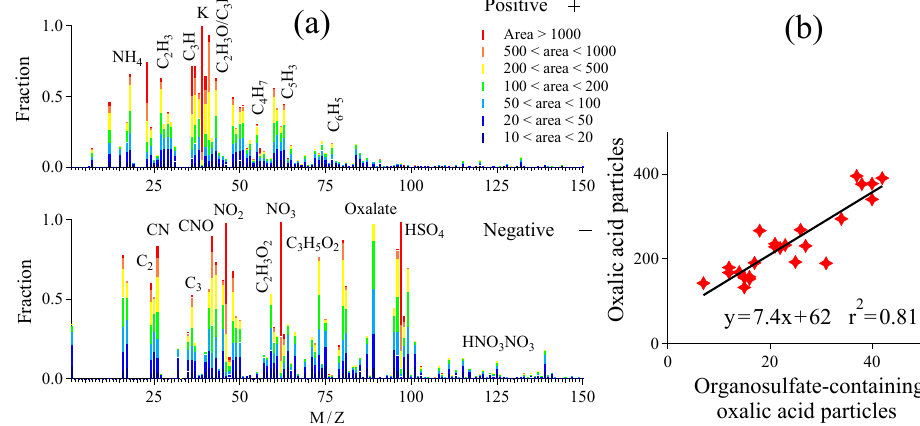
Figure 10. The comprehensive study of oxalic acid particle increase on 8 February 2015: (a) the digitized positive and negative ion mass spec- trum of oxalic acid particles during the haze episode; (b) linear regression between total oxalic acid particles and organosulfate-containing oxalic acid particles ( m/z ∼ − 155).